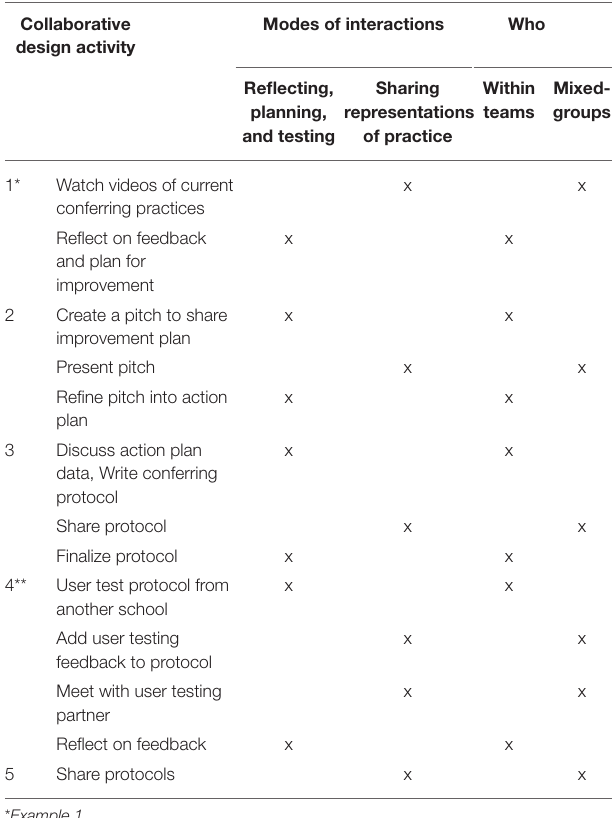
TABLE 2 | Collaborative design activity sequence during the 90-day design